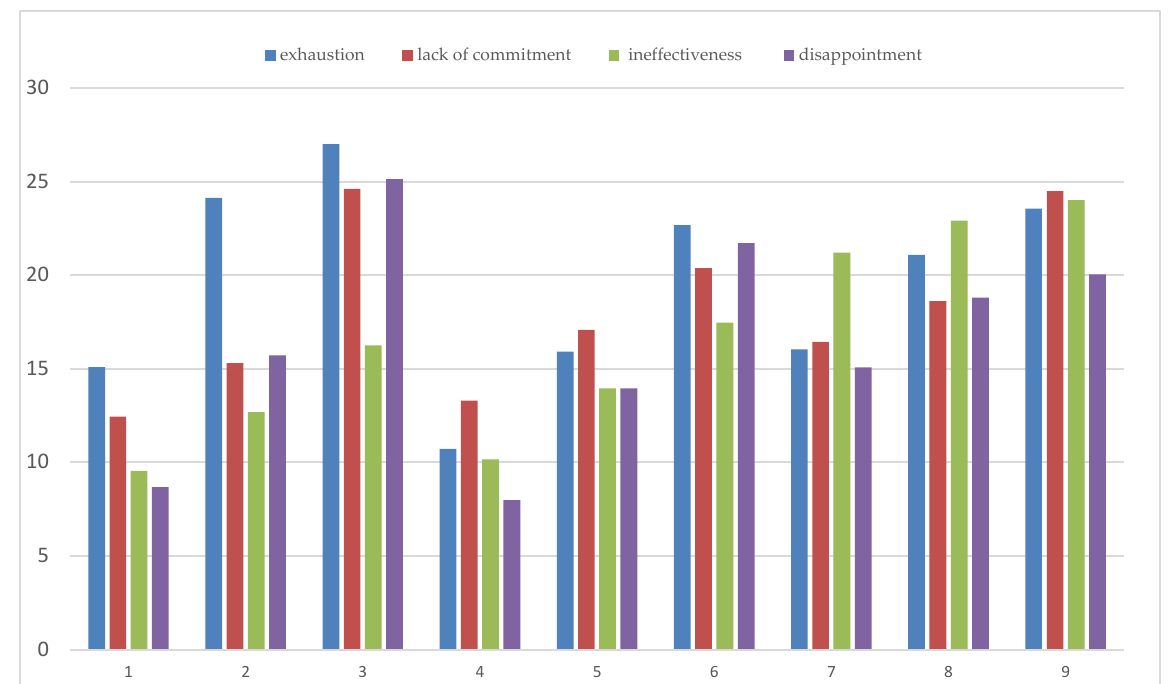
Figure 1. Intensification of occupational burnout dimensions in the analyzed profiles. Note. Profiles in a group of Air Traffic Controllers: 1—engaged, with a reduced sense of effectiveness, 2—reduced sense of effectiveness, 3—burned out with a low sense of effectiveness; profiles in a group of fire- fighters: 4—at low risk of burnout with a psychophysical exhaustion component, 5—exhausted with a moderate tendency to disappointment, 6—burned out, ineffective, and uninvolved; profiles in a group of ECD: 7—not burned out, 8—at risk of professional burnout, 9—exhausted with a tendency to